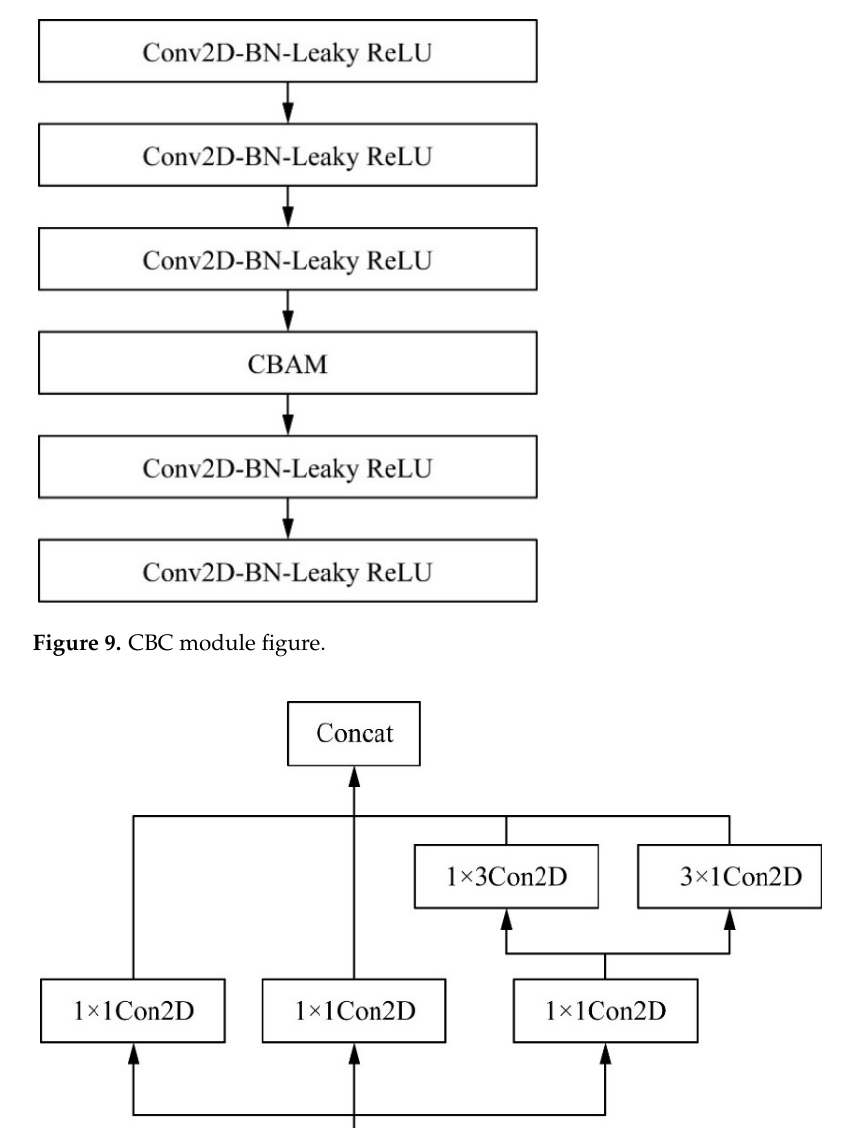
Figure 11. MobileNetv2-YOLOv4 network structure figure.